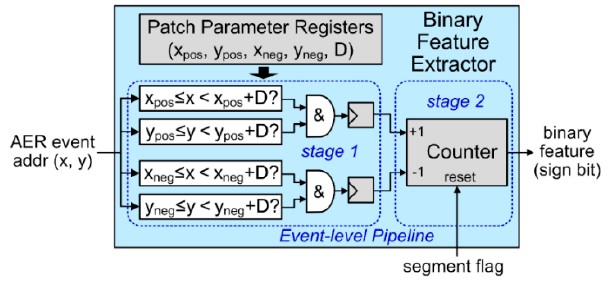
Figure 4. T he circuit of the binary feature extractor. Figure 4. The circuit of the binary feature extractor.